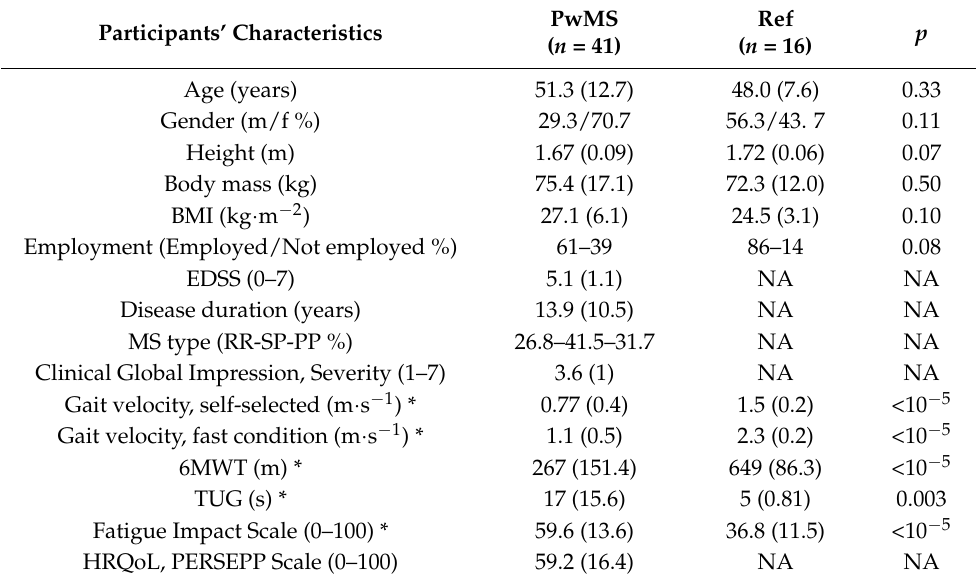
Table 1. Means and (SD) of participants’ characteristics.